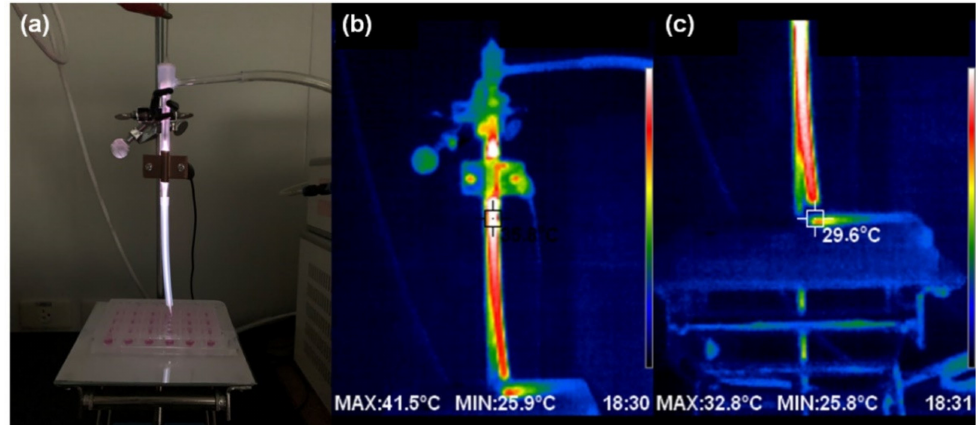
Figure 4. ( a ) The image of transferred cold atmospheric plasma, ( b , c ) thermal images captured by the IR camera.